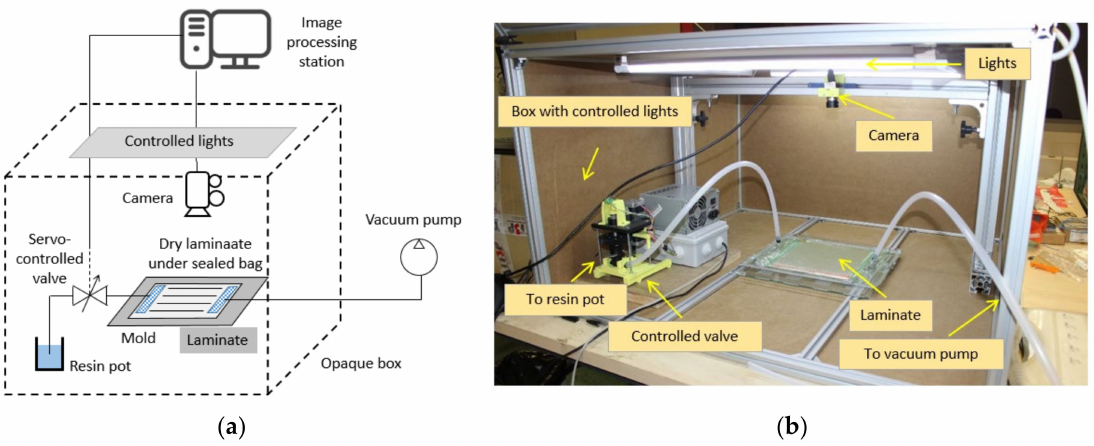
Figure 2. ( a ) Schematic of the setup; and ( b ) laboratory